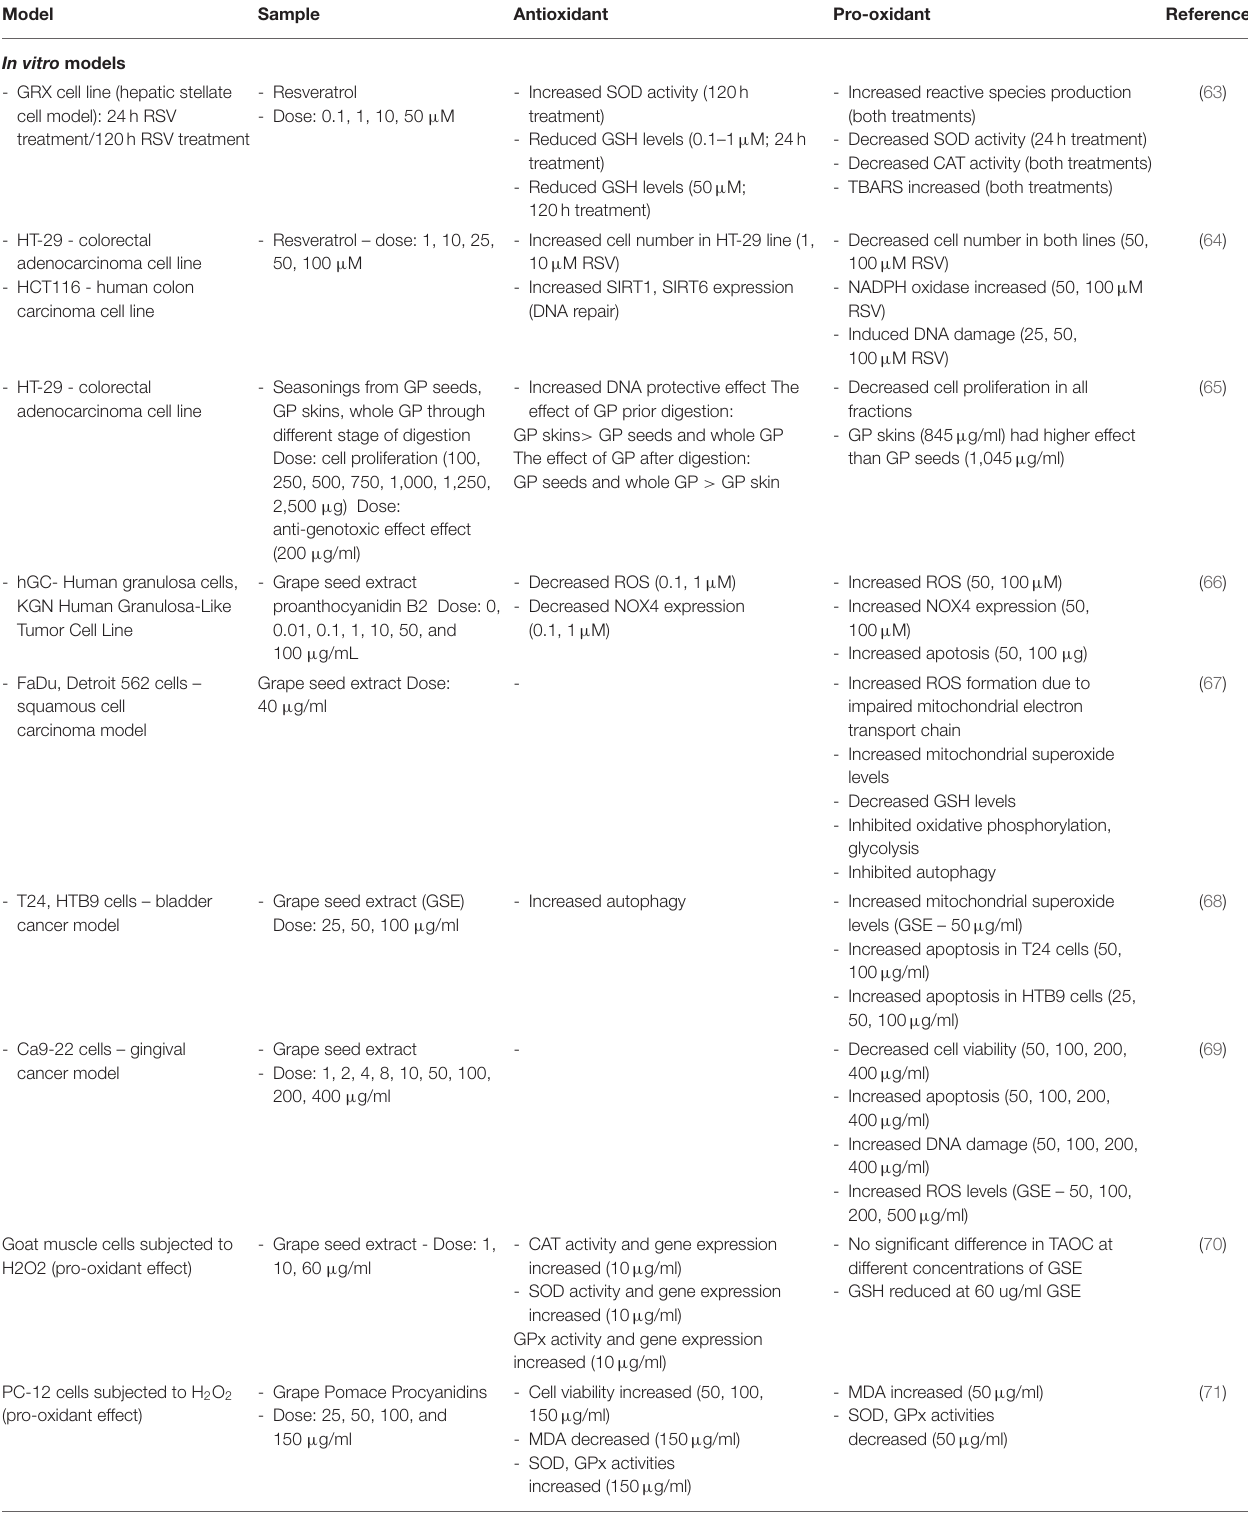
TABLE 1 | In vitro and in vivo evidence of antioxidant and pro-oxidant effect of resveratrol and polyphenols from grapevine and wine by-products.